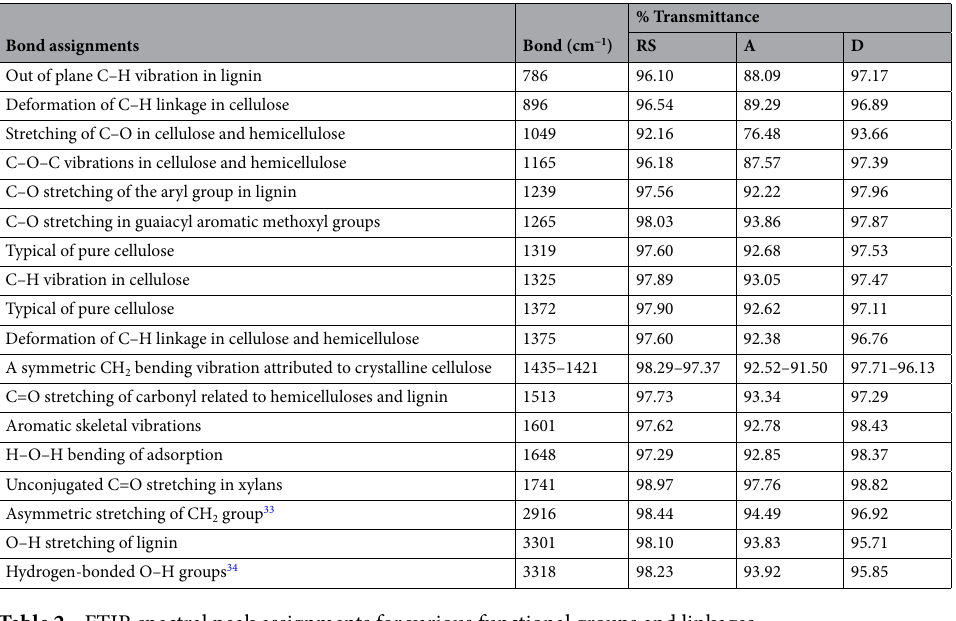
Table 2. FTIR spectral peak assignments for various functional groups and